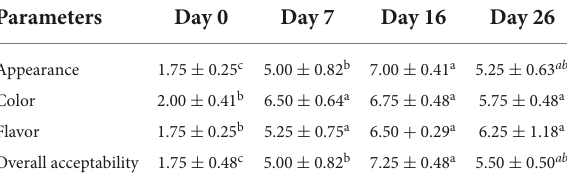
TABLE 4 Sensory quality (means ± standard error) of fermented mutton sausage during natural